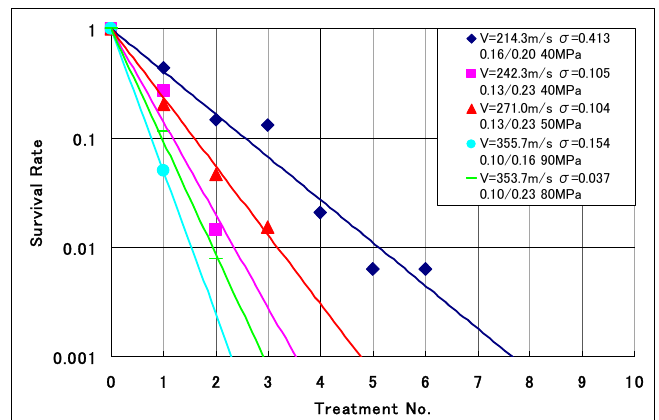
Fig. 9. Survival rate vs number of passes for E. coli